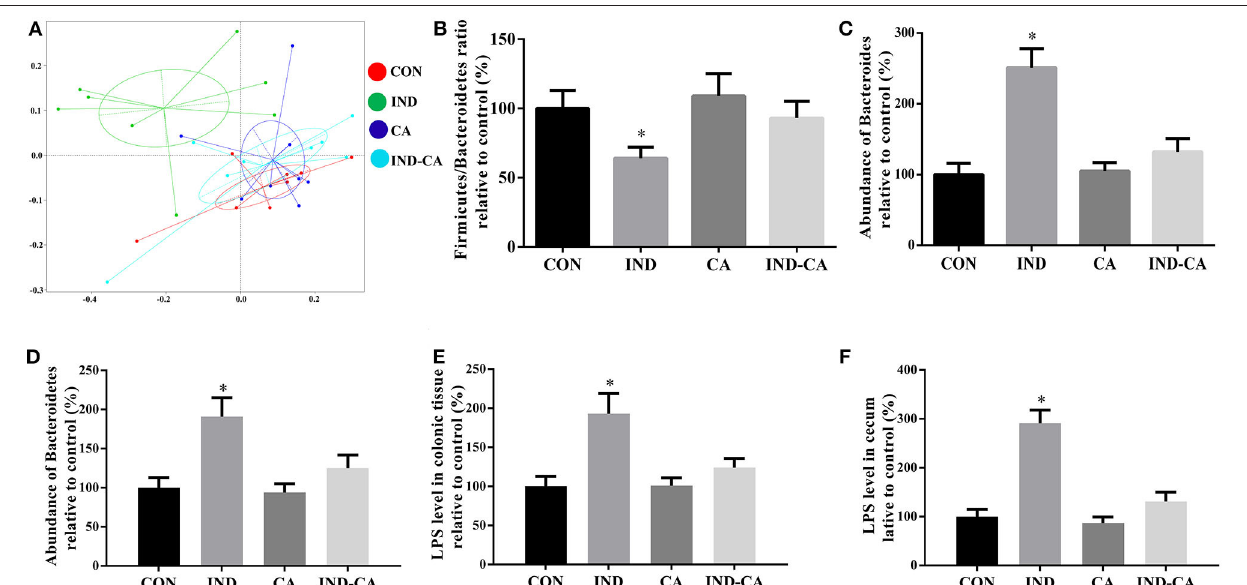
FIGURE 4 | Chlorogenic acid decreased Bacteroides -derived LPS content in indomethacin-treated mice. (A) PCoA plot of the cecum microbiota; (B) Relative ratio of Firmicutes to Bacteroidetes ; Relative abundance of Bacteroides at the genus level (C) and Bacteroidetes at the phylum level (D) ; Relative LPS content in the colonic